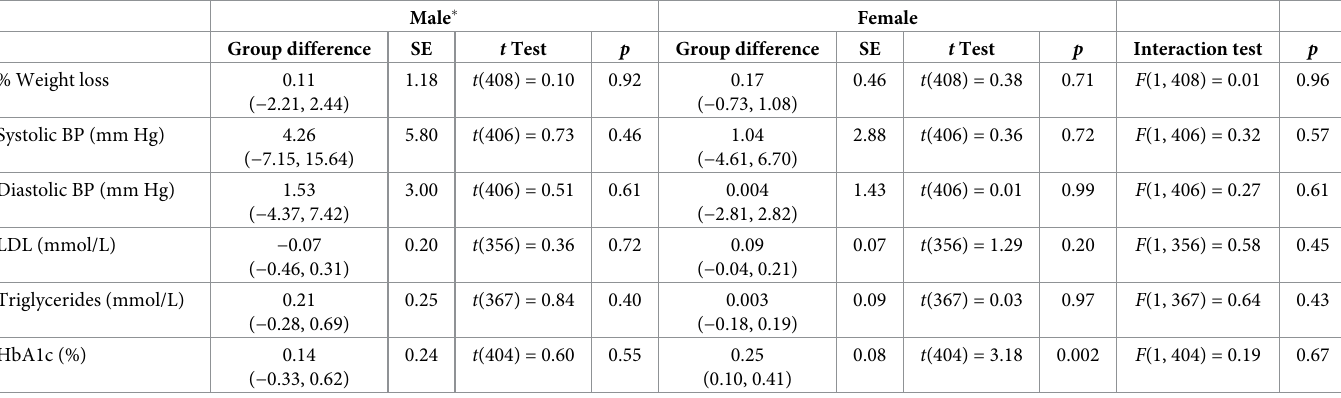
Table 4. ANCOVA models separated by